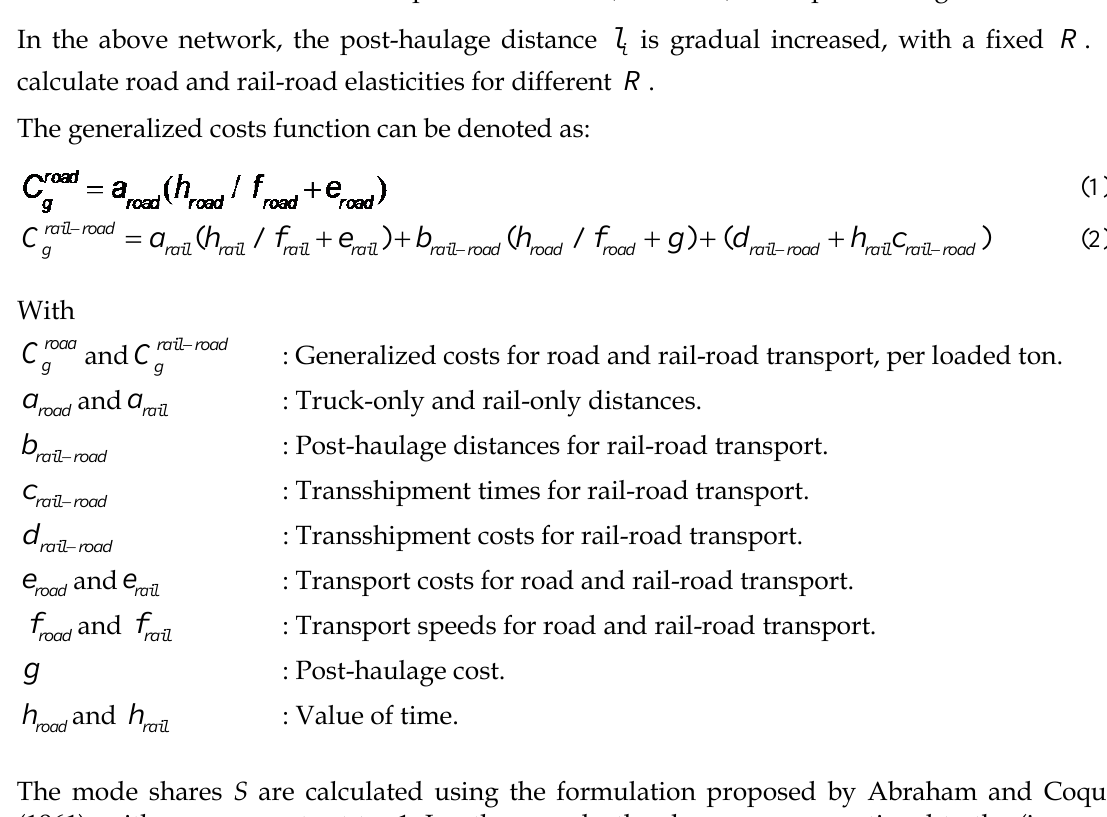
Figure 1. Intermodal network consisting of truck-only and rail-road transport The stylized model is based on a simple theoretical single origin–destination relation, between which both road only and intermodal transport are possible, and is illustrated in Figure 1 by means of a fan-shaped diagram. Both O and T are terminals, and D i (i=0,1,…,n) are various customers distributed around terminal T . R is road transport distance, and r is the rail transport distance within the rail-road transport route, and l i (i=0,1,…,n) is the post-haulage